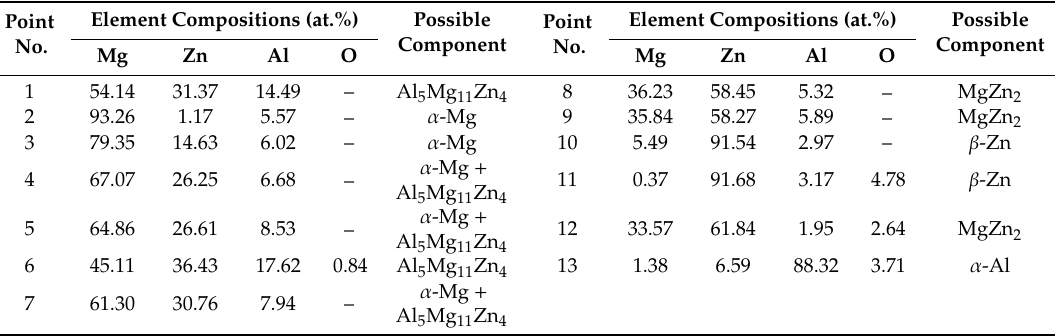
Figure 8. SEM micrographs of the interface in arc-sprayed Al / AZ91D with a Zn interlayer (arc-spraying Zn for 30 s and Al / Zn double-deck coating preheated for 12 h): ( a ) general view, ( b – f ) areas A, B, C, D, and E in ( a ), respectively. Table 7. EDS analysis results corresponding to the points marked in Figure